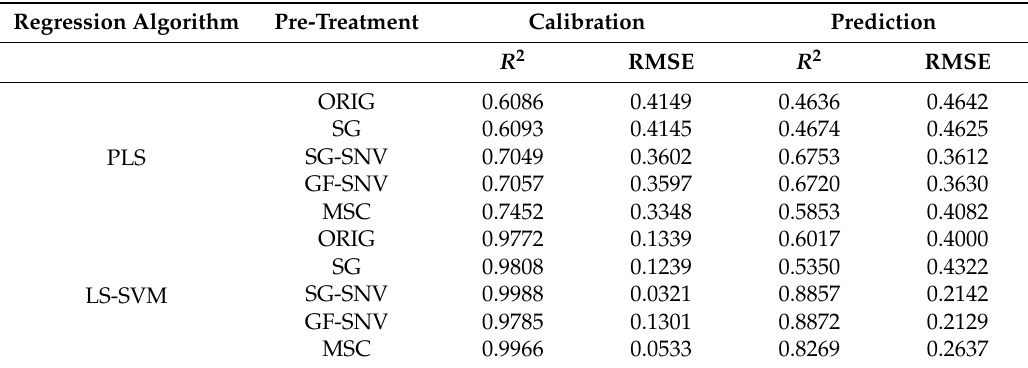
Table 1. Results of models with different spectral pre-treatments. Regression Algorithm Pre-Treatment